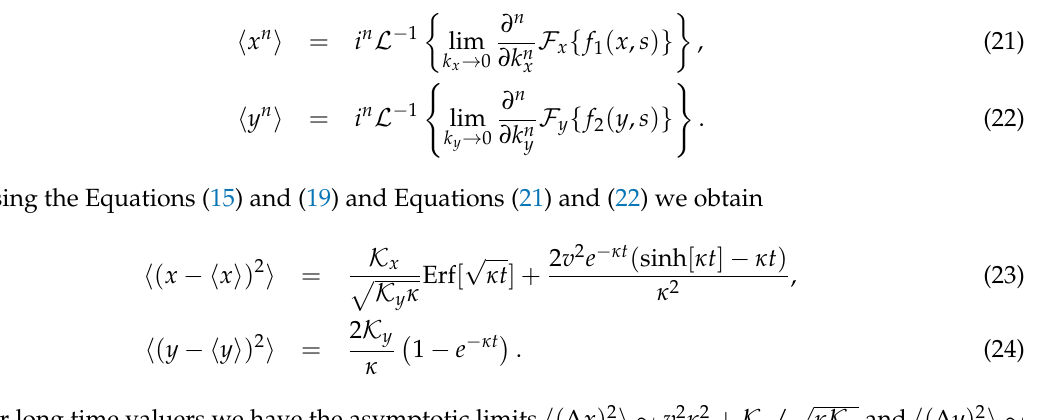
Figure 3. This figure represents time evolution behavior to marginal distribution in x -axis (Equation (15) to non-static stochastic resetting. In this figure, we consider the parameter valuers as follow = 1, v = 1 and κ = K y